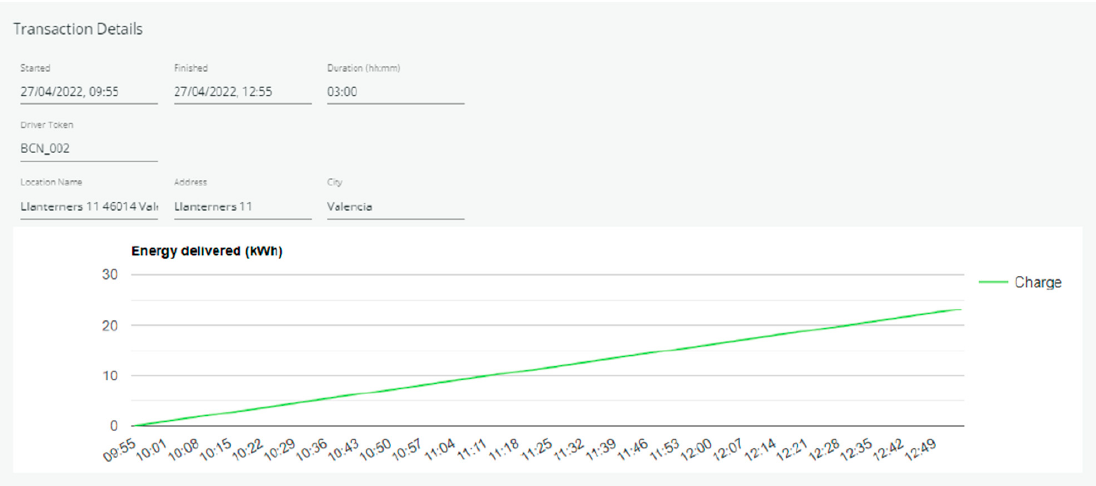
Figure 6. TwinEV dashboard. Details of a finished transaction.